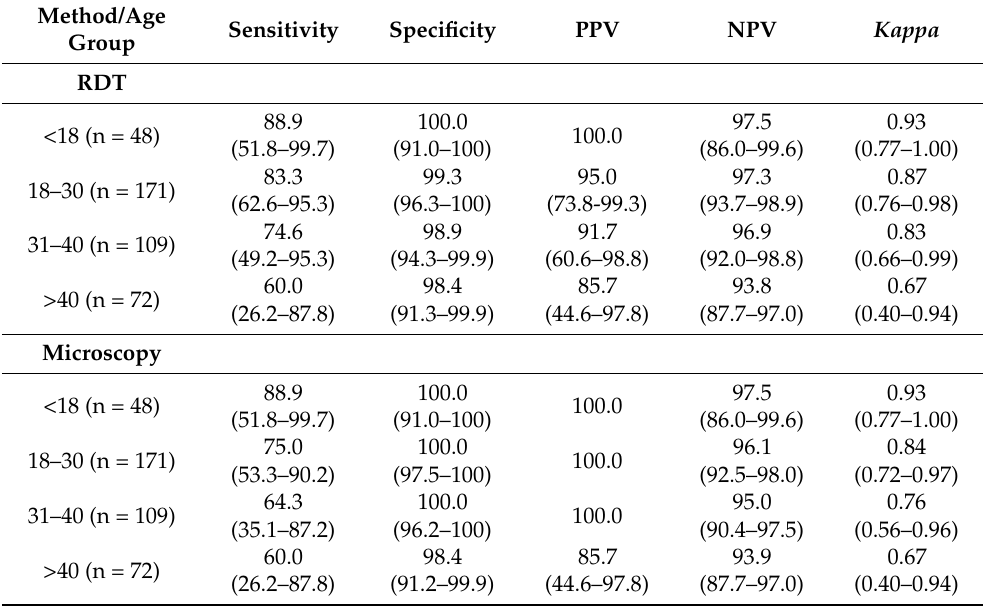
Table 3. Age-stratified performance of light microscopy and RDT techniques in the diagnosis of malaria against PCR as reference method.